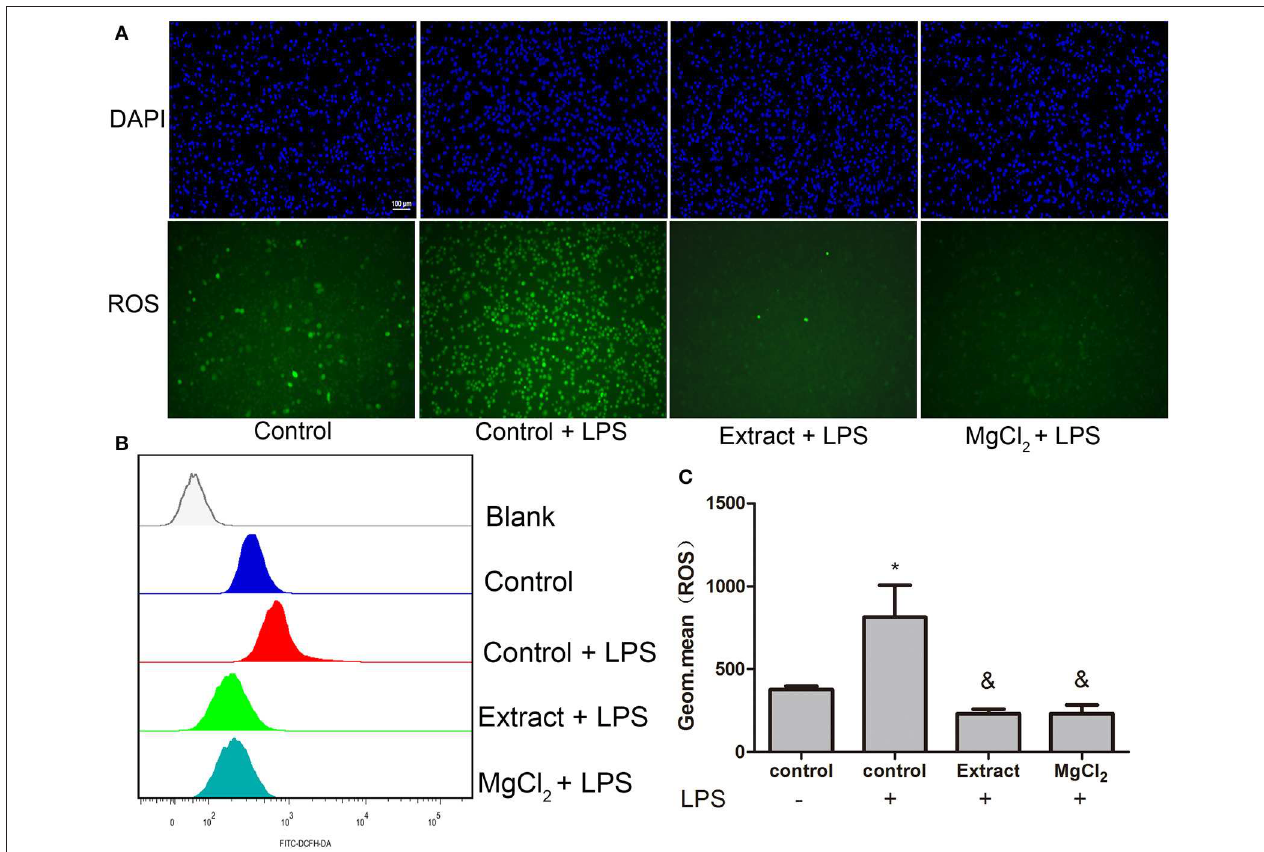
FIGURE 8 | Effects of extract and MgCl 2 on antioxidants in LPS-induced THP-1 cell-derived macrophages. Cells were pretreated with MgCl 2 or extract for 1h and then stimulated with LPS for 1h. (A) The ROS level of THP-1 cell-derived macrophages was assayed by fluorescence microscopy using a DCFH probe. Scale bar = 100 µ m. (B,C) The expression of intracellular ROS was also detected by FACS using a DCFH probe. The representative images from three experiments are shown. * P < 0.05 vs. control group; & P < 0.05 vs. LPS-induced control group. LPS, lipopolysaccharide; ROS, reactive oxygen species; DCFH, dichlorodihydrofluorescein diacetate; FACS, fluorescence-activated cell